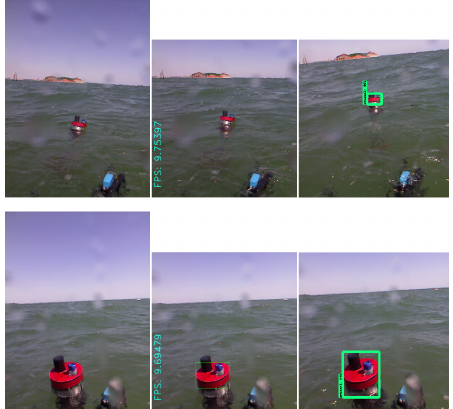
Figure 25. Two examples of image processing on the aPad during docking experiments in a realistic environment. From left to right: original image, hue thresholding output, neural network detection output. Note the neural network output being a frame behind the hue